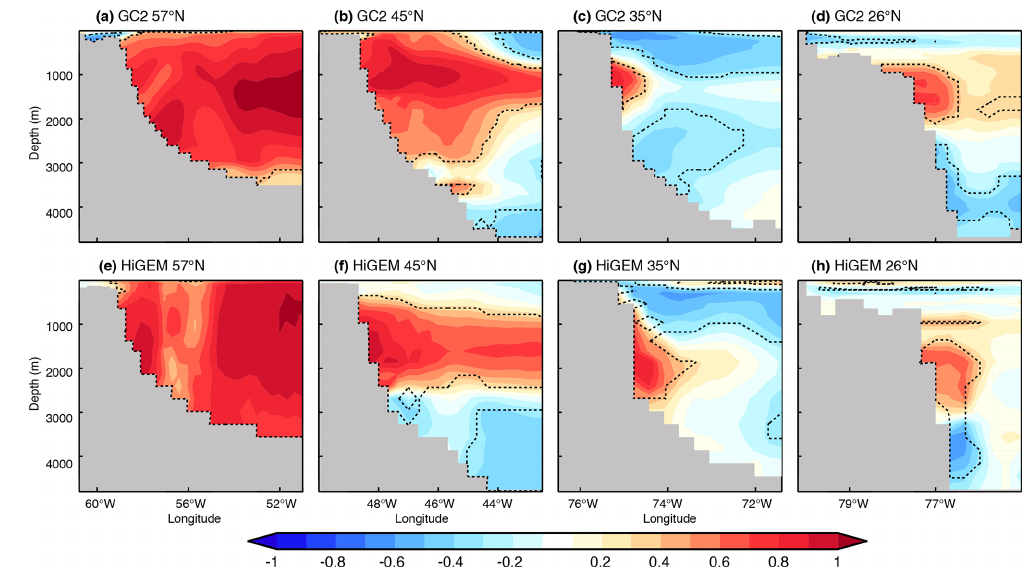
Figure 10. (a) In-phase correlation in GC2 between the PC1-LSD index and the density fields across a zonal section at 57 ◦ N located in the vicinity of the western Atlantic boundary. Thin dashed contours enclose areas where the correlation significance exceeds the 95% confidence level. Correlations are based on 10-year running trends. (b–d) The same as in (a) but for zonal sections at 45, 35, and 26 ◦ N. (d–h) The same as in (a–d) but for